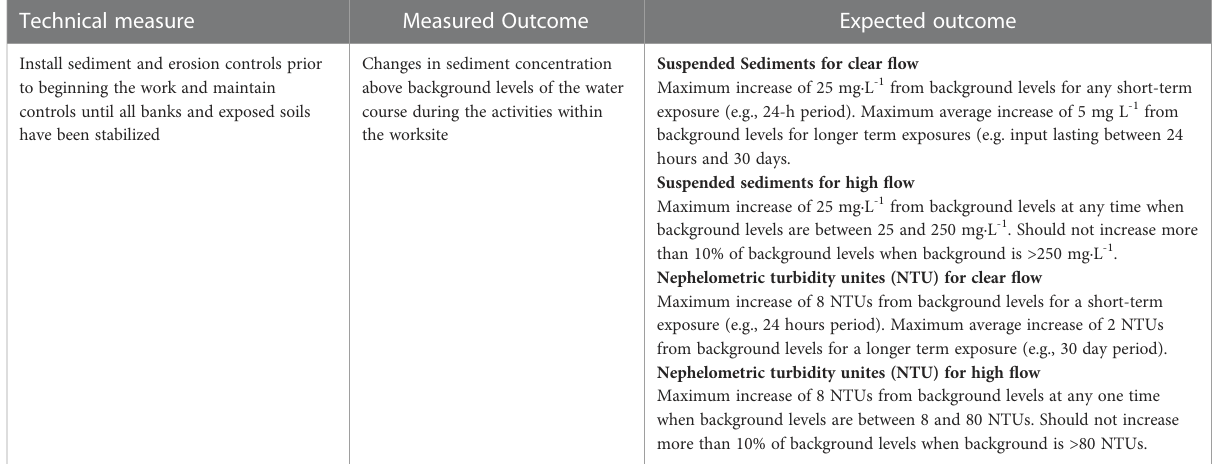
TABLE 5 Canadian Water Quality Guidelines for the Protection of Aquatic Life - Total Particulate Matter (CCME, 2002). Technical